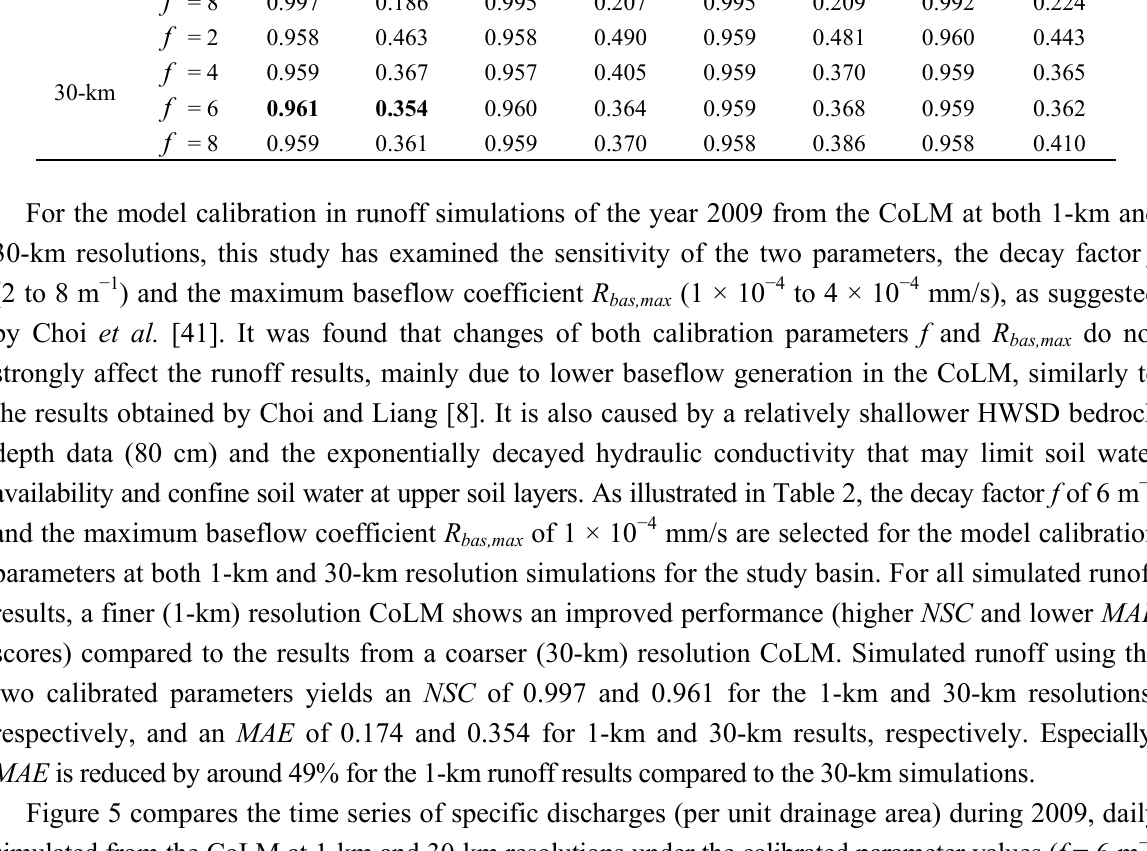
(in mm/sec) changes bas,max